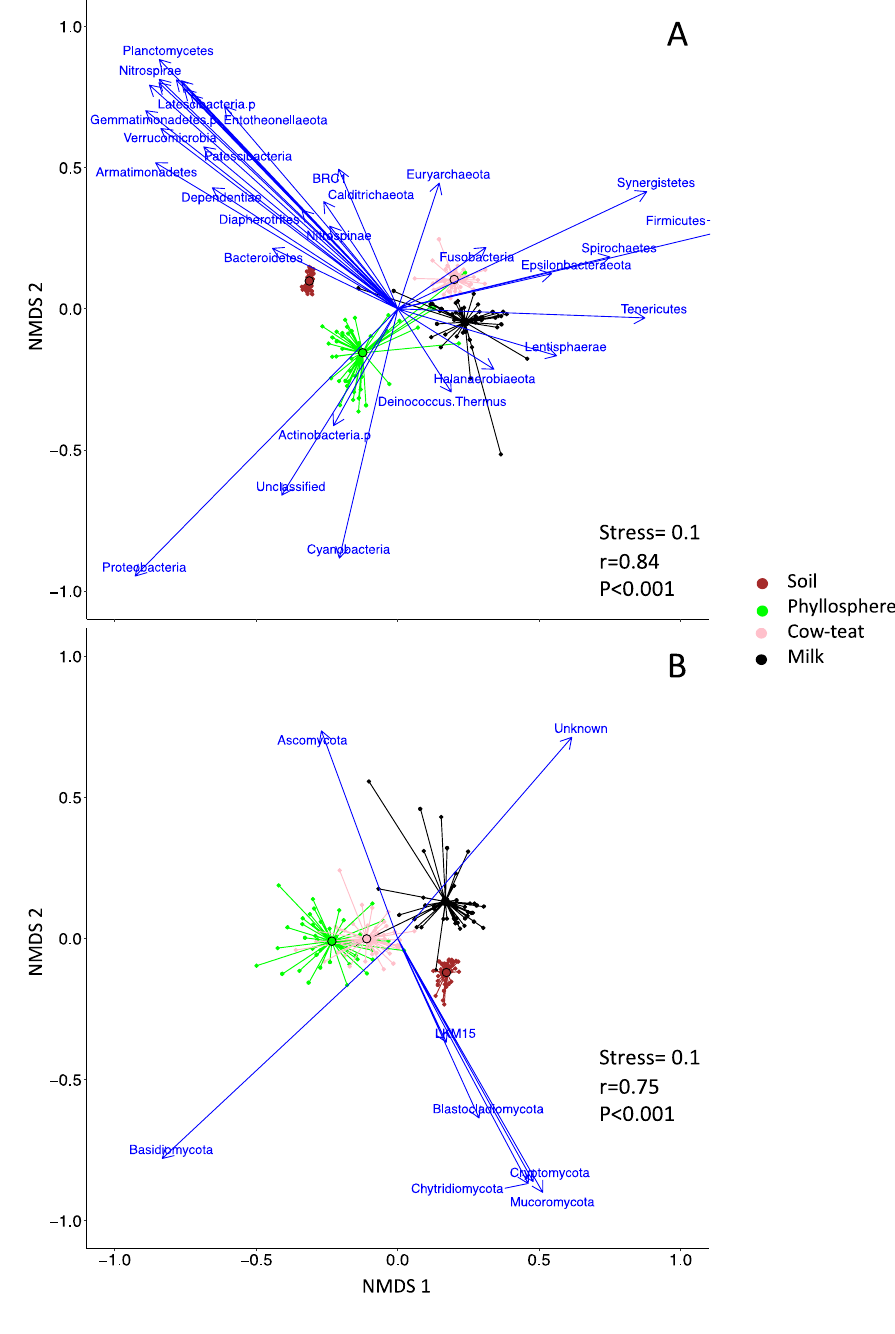
Figure 1. NMDS representation of bacterial-archaeal ( A ) and fungal ( B ) community structure variations across compartments based on the relative abundance of affiliated genera data. For each compartment, each sample from one farm is related to the centroid of the compartment (black lined dot), the total number of samples per compartment was n = 44. Blue arrows represent phylum data fitted by means of envfit function ( vegan package) in NMDS space for which P < 0.001. Stress value indicate the quality of NMDS representation; r and P values correspond to the results of the ANOSIM